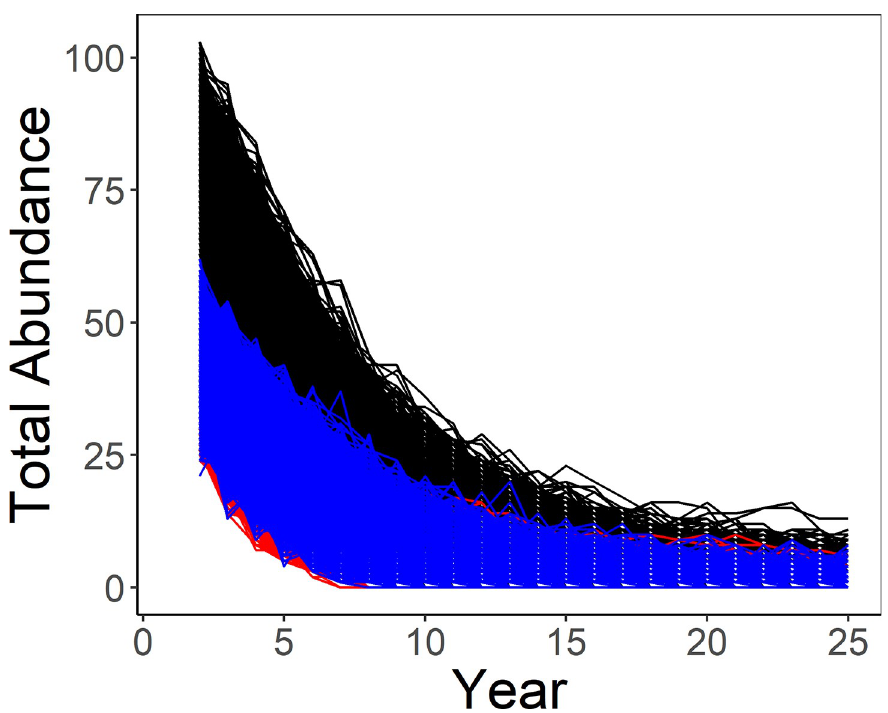
Fig 1. Simulated total lesser prairie-chicken abundance. Simulated (Scenario 2) total lesser prairie-chicken population abundance (black) from 100 individual-based model simulations of 300 sites with male abundance (blue) and female abundance